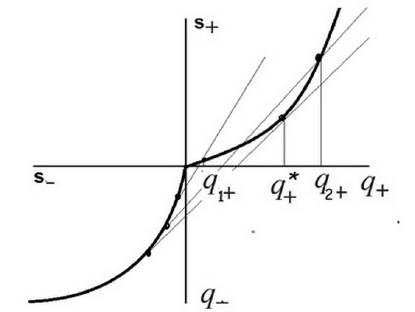
Figure 1. The dependence of the entropy flux on the heat flux supplied and removed from the working